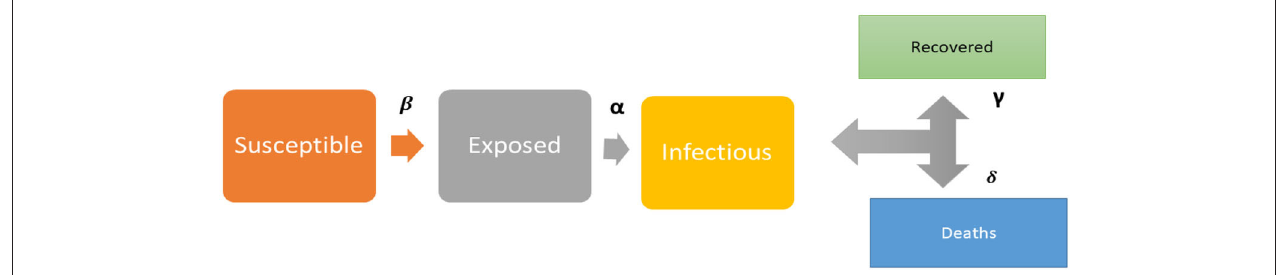
FIGURE 1 | Conceptual framework of the SIER